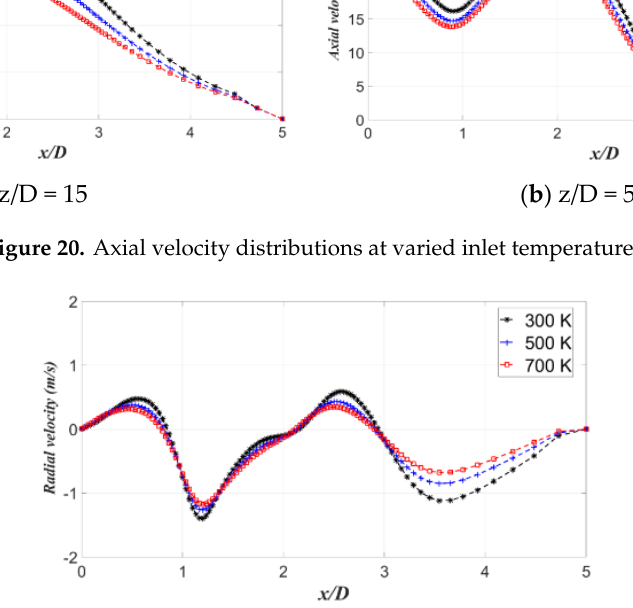
Figure 21. Radial velocity distributions at varied inlet temperatures (z/D = 5).